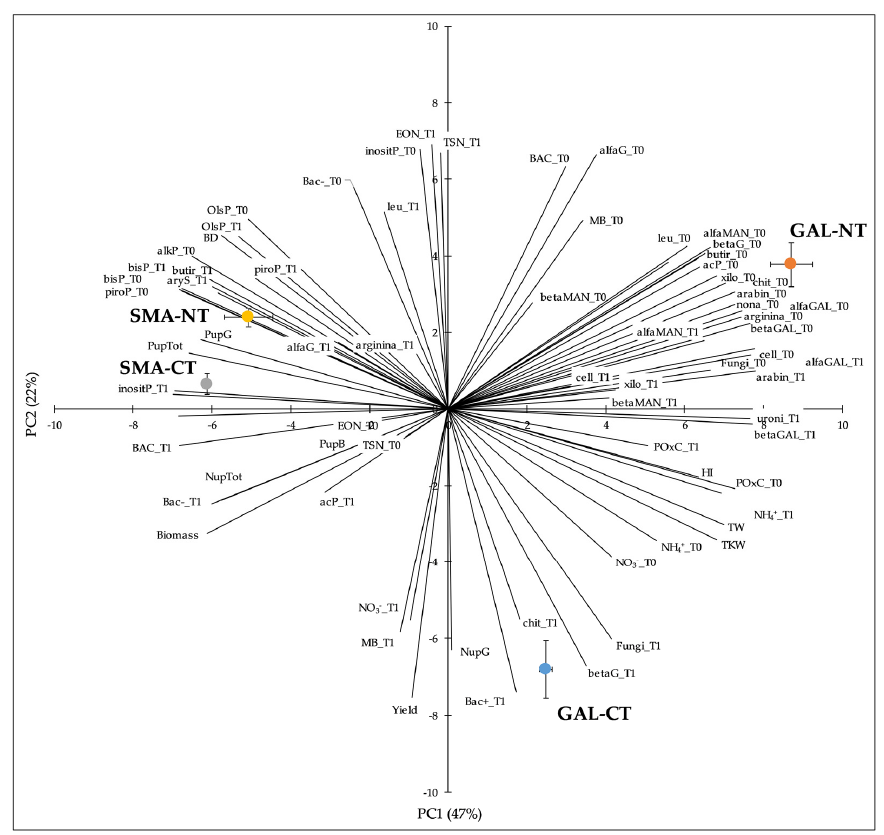
Figure 7. Principal component analysis biplot of the four cropping systems centroids calculated (means ± SEs) as combinations of experimental soils (GAL and SMA) and tillage managements (CT and NT). PC1, first principal component; PC2, second principal component. The direction and length of vector lines indicate the degree of association between each variable, as specified in the M&M section, and the cropping system.